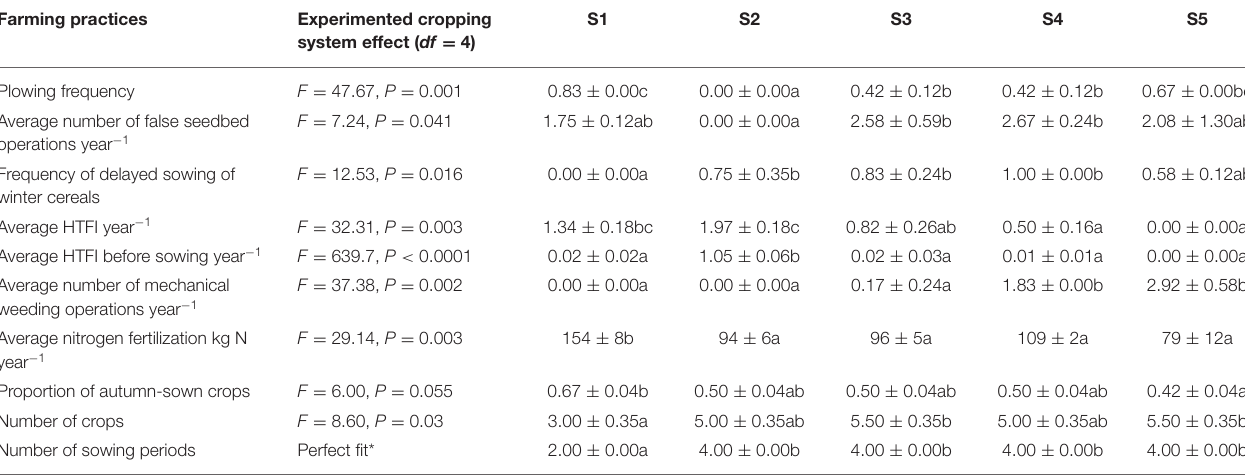
TABLE 1 | Differences in terms of farming practices between experimented cropping systems (over the 2012–2017 period). Farming